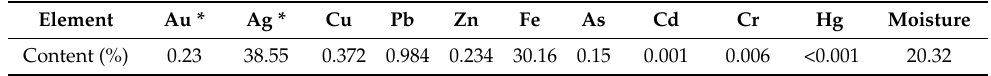
Table 1. Chemical composition analysis of cyaniding tailings after primary air-drying. Element